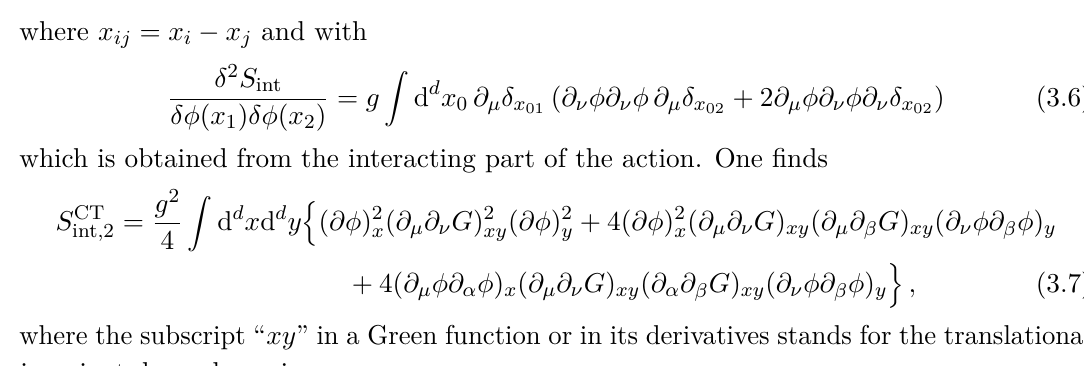
Figure 1 . Diagram in coordinate representation for the one loop corrections to the quartic